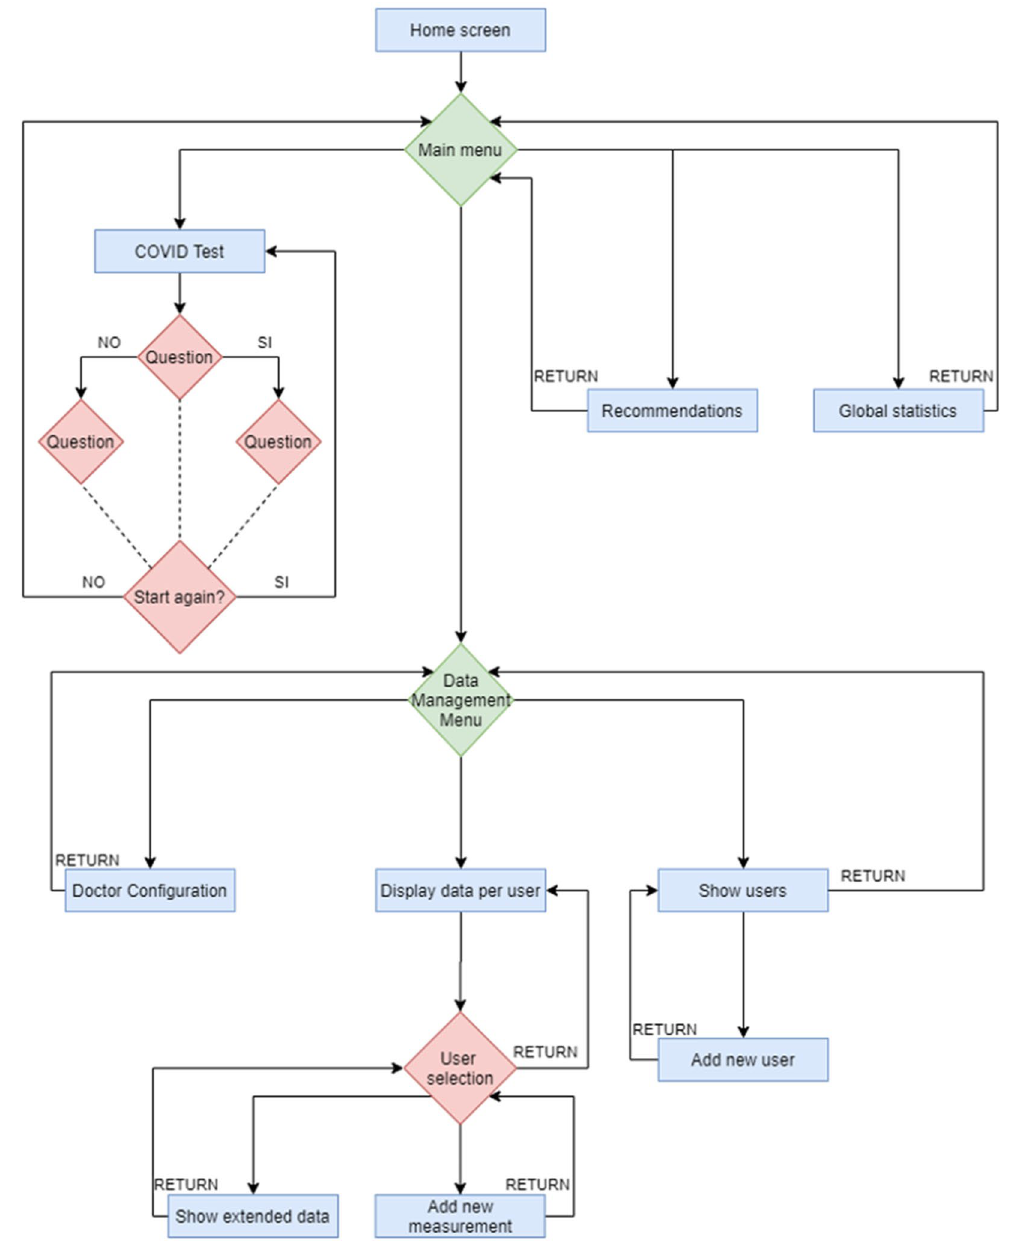
Figure 5. Flowchart of the different screens of the